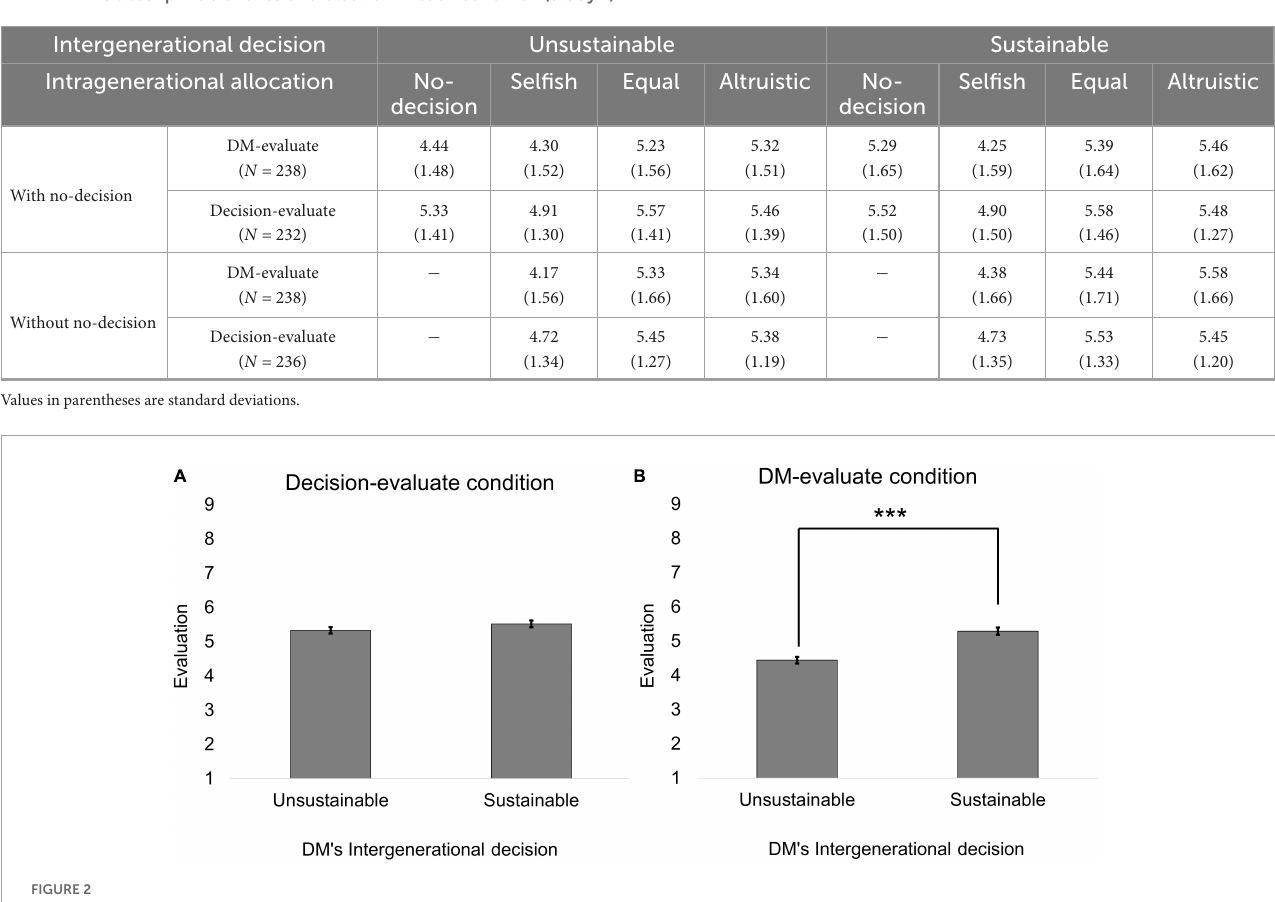
TABLE 4 The descriptive statistics of evaluation in each condition (Study 1).